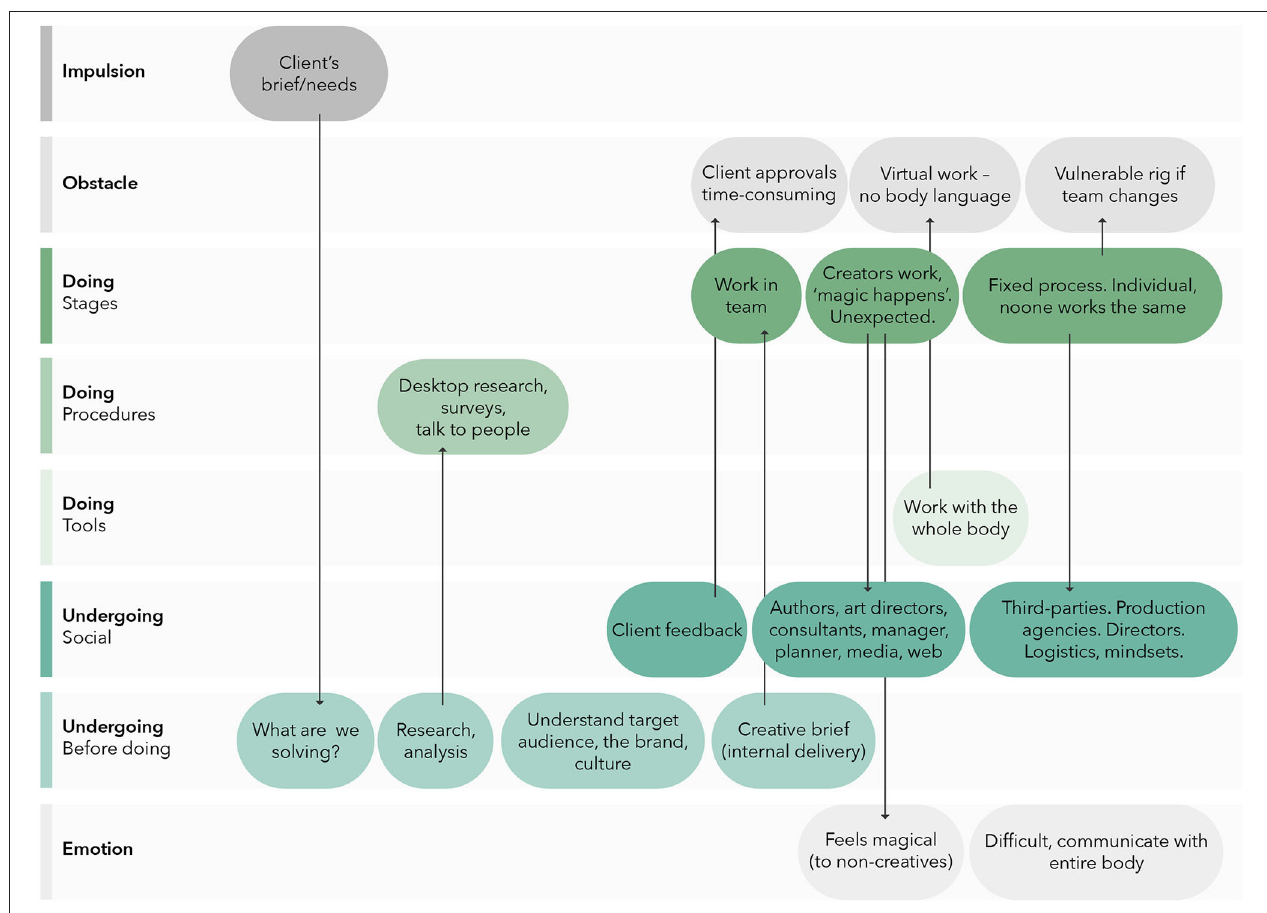
FIGURE 6 | A flow chart representation of creative activity as explained by advertising